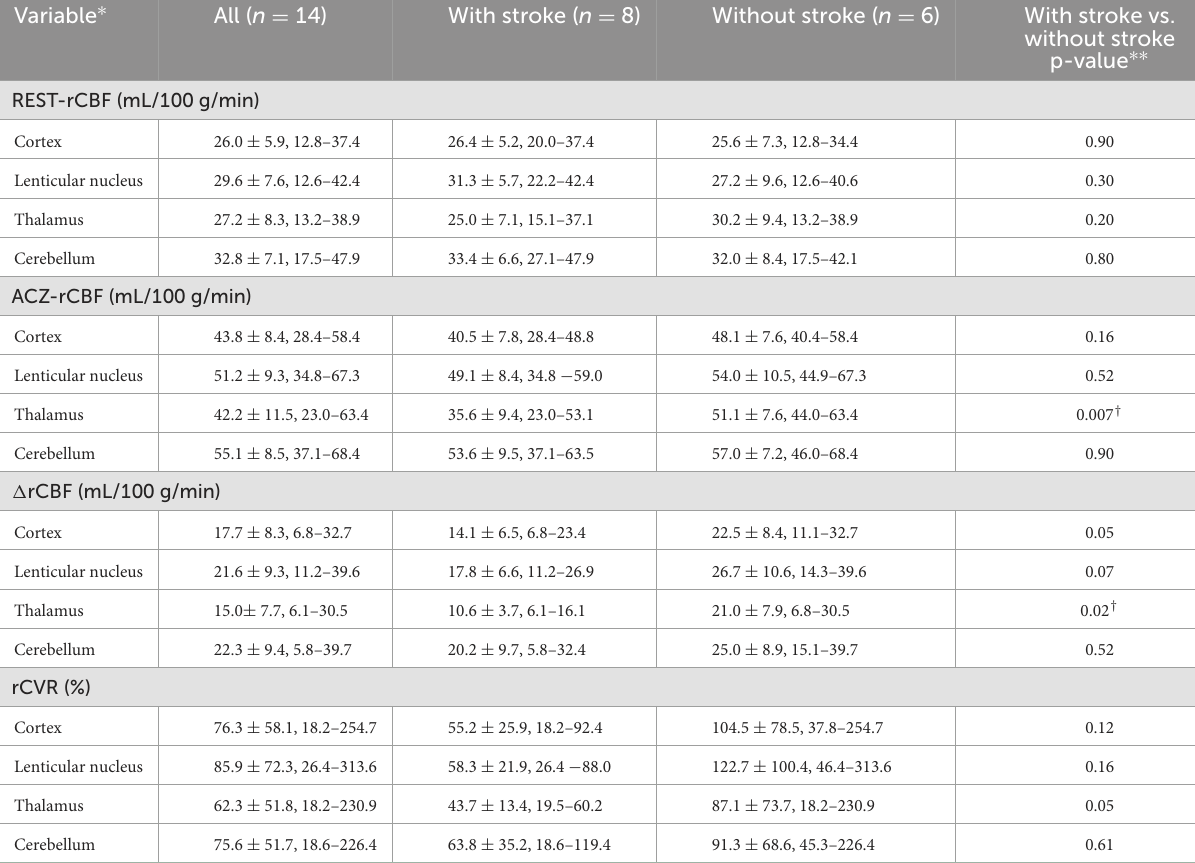
TABLE 2 Comparison of the cerebral blood flow parameters between patients with and without stroke.